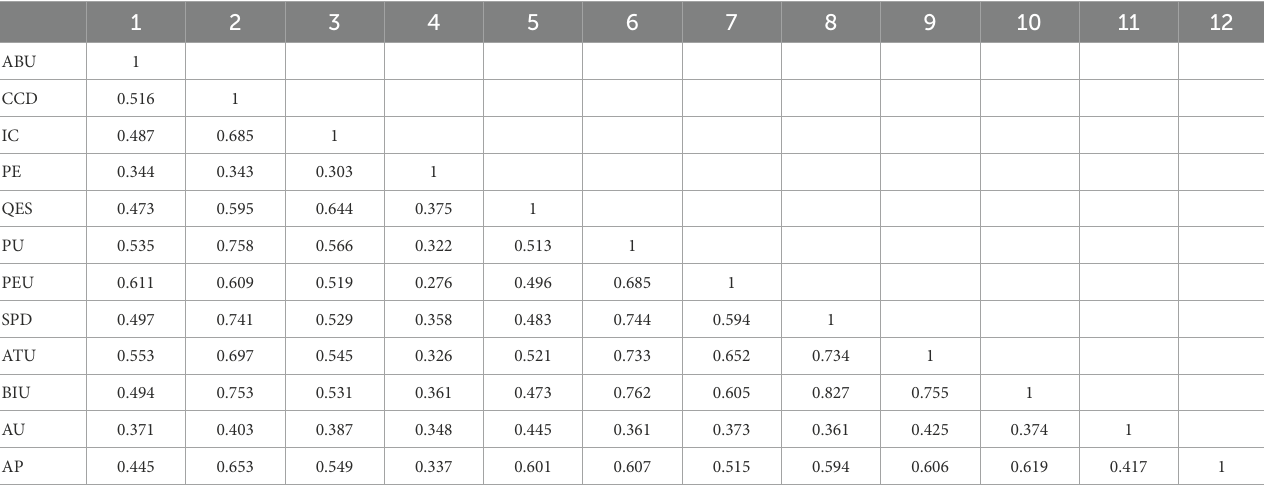
TABLE 3 Correlation matrix.